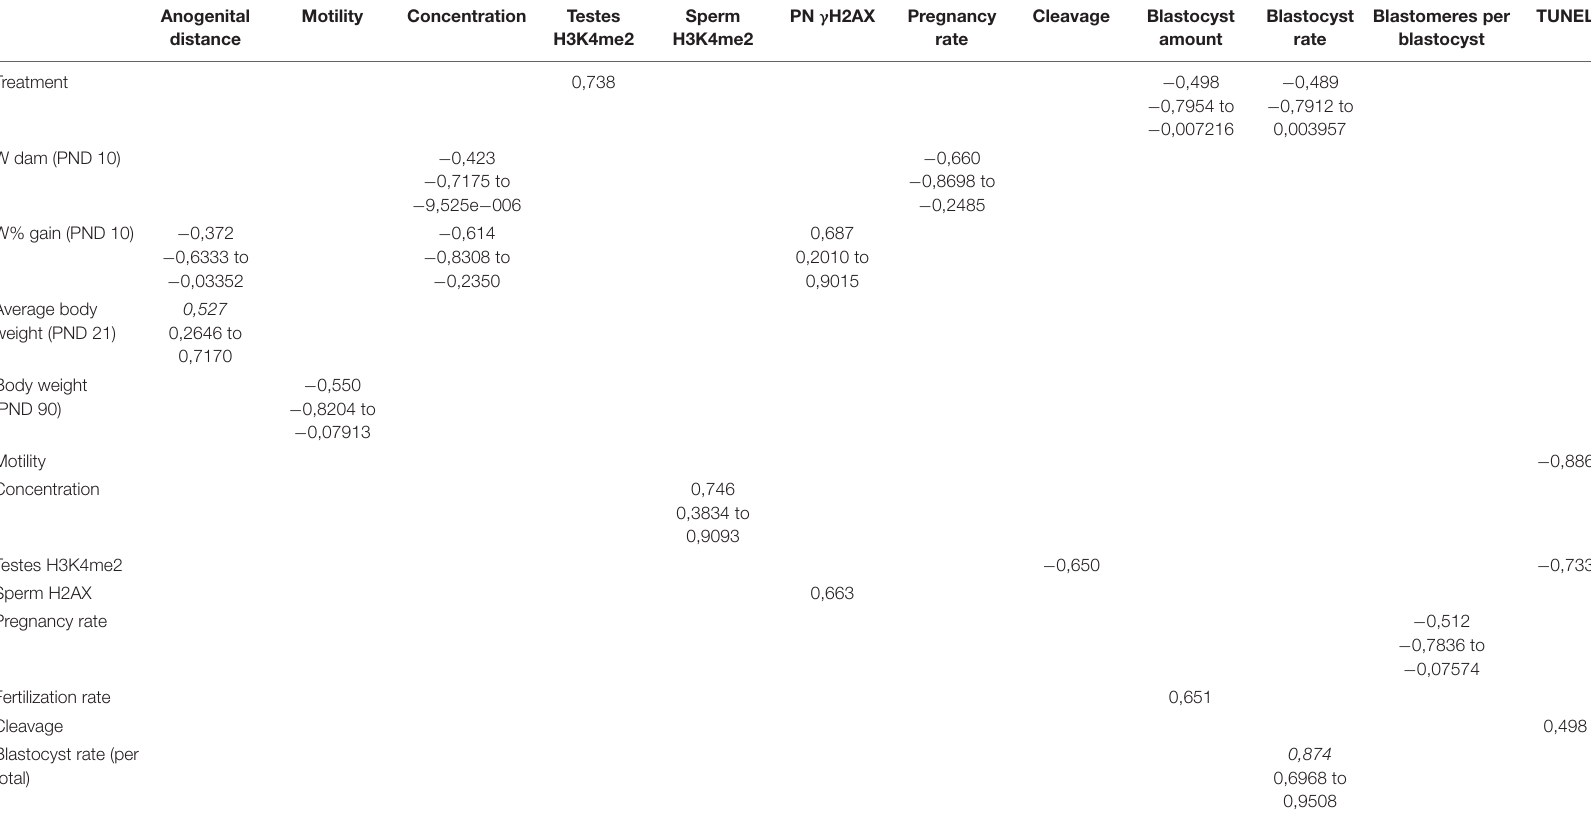
TABLE 1 | Correlations between selected parameters.